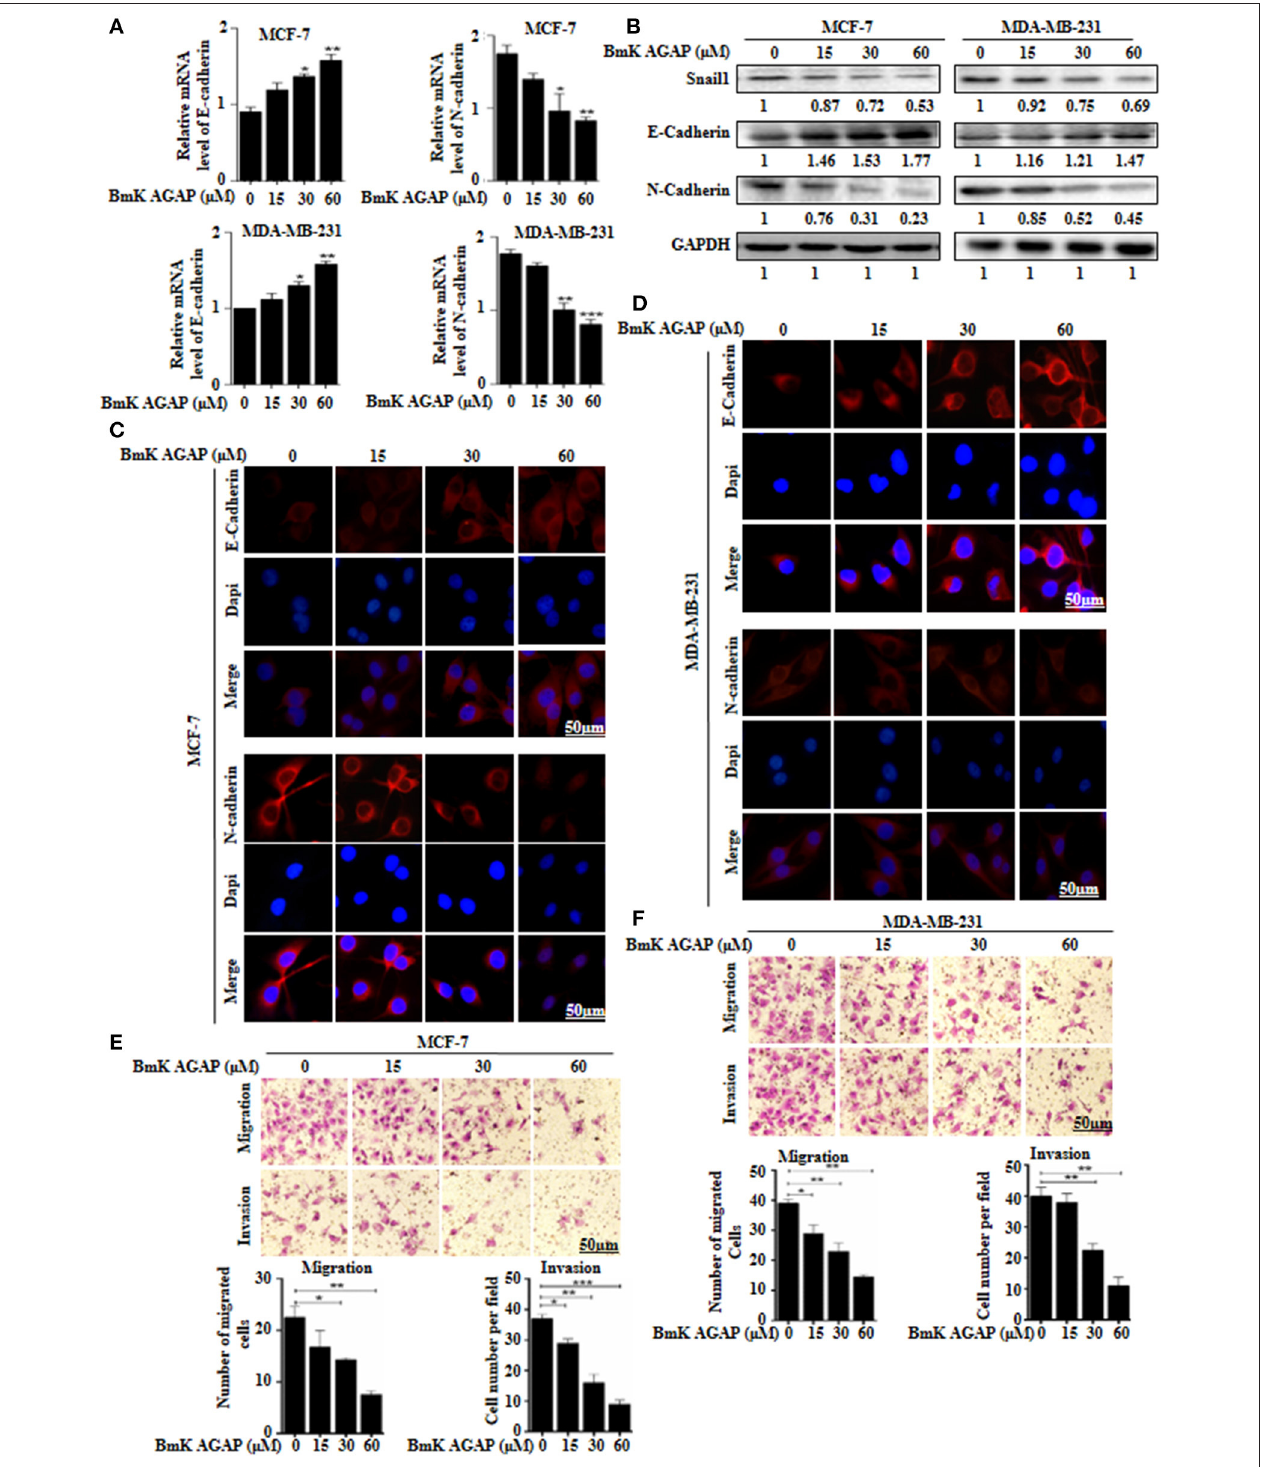
FIGURE 4 | BmK AGAP inhibits epithelial-mesenchymal transition (EMT) of breast cancer cells. (A) Relative gene expression of N-cadherin and E-cadherin in MCF-7 and MDA-MB-231 cells treated with different concentrations of rBmK AGAP. GAPDH served as internal control. (B) Protein expression levels of Snail1, N-cadherin, and E-cadherin following rBmK AGAP treatment of MCF-7 and MDA-MB-231 cells. The cells were treated for 48h, lysed, subjected to SDS-PAGE and analyzed by western blotting with antibodies against Snail1, N-cadherin, and E-cadherin. (C,D) Immunofluorescence assessment of cadherin and N-cadherin in MCF-7 and MDA-MB-231 cells following rBmK AGAP treatment. MCF-7 and MDA-MB-231 cells were stained with anti- E-cadherin and N-cadherin antibodies (red)